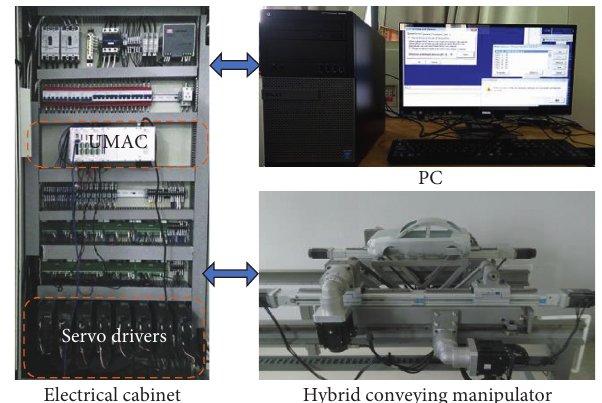
Figure 8: The hybrid conveying mechanism prototype.